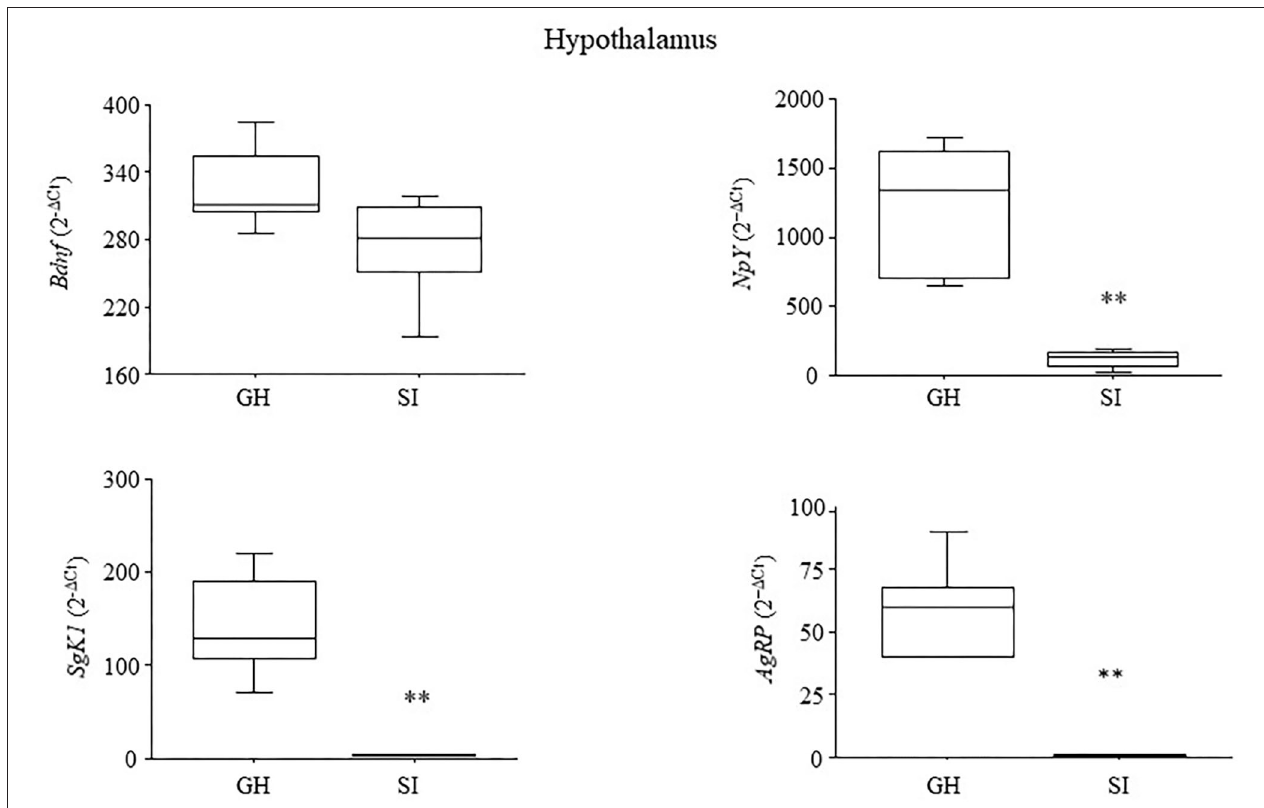
FIGURE 3 | Hypothalamic gene expression. Chronic social isolation stress resulted in the decrease in the expression levels of genes specifically involved in stress reactivity ( SgK1 ), and metabolism ( NpY and AgRP ). Expression of the neurotrophin Bdnf was somewhat reduced but not significantly after 4 months of IS. Raw data were transformed using the square root and are presented graphically as means ± SEM box plots (observations outside the ranges are represented with dots outside the boxes). ** p < 0.01. Number of subjects: 4–5 within each experimental